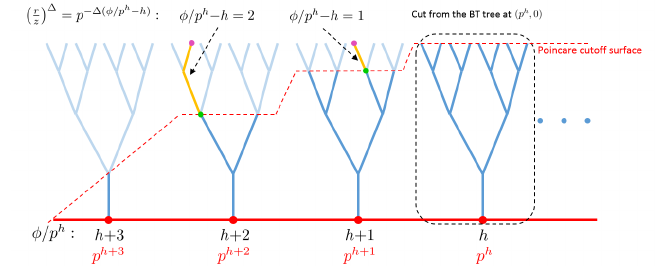
Figure 9. Computing 2 point functions in the cylinder type black hole